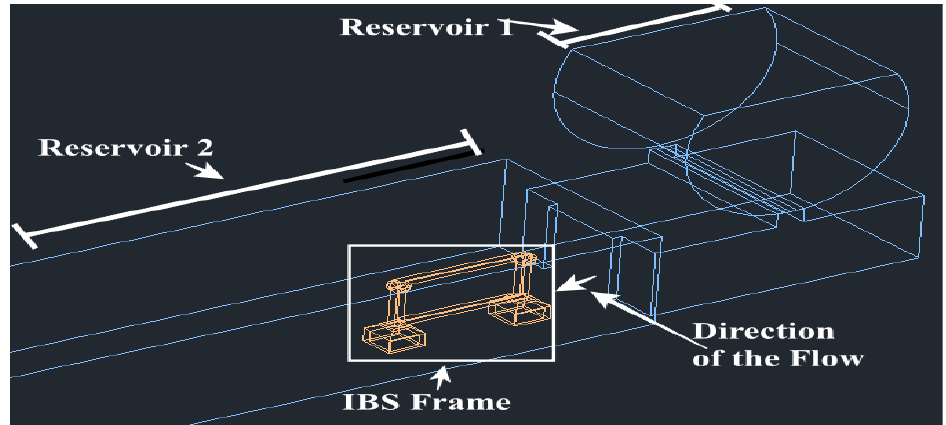
Figure 11. The testing tank with the model.